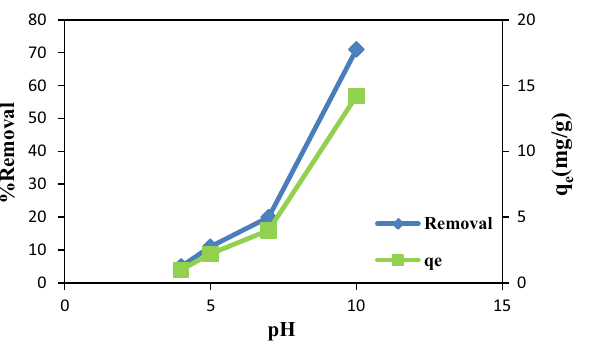
Fig. 2 Effect of adsorbent dosage on Ni(II) adsorption onto MWC- NTs. (Time 5 min, optimum pH 10, initial nickel concentration: 50